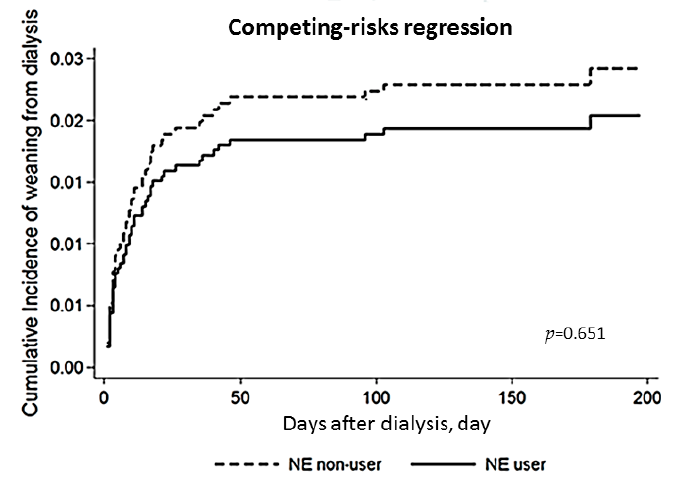
Figure 3. Cox proportional plot depict cumulative proportions of renal recovery between NE user and non-user groups. There was no significant difference ( p = 0.651) in weaning from dialysis between NE user group and non-user group when taking mortality as a competing risk. BUN: blood urea nitrogen; GAM: generalized additive model; NE: norepinephrine.